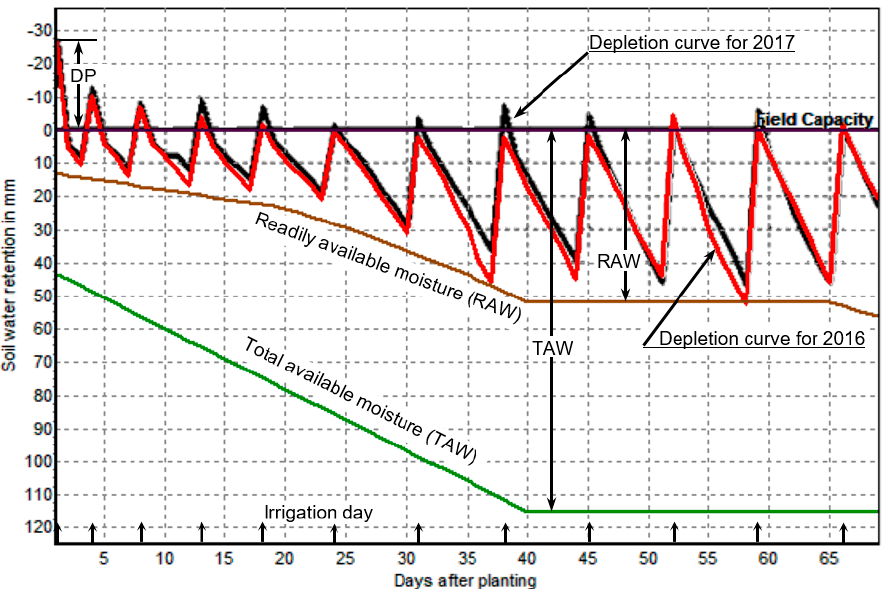
Figure 6. Soil water depletion during the 2016 and 2017 growing seasons.